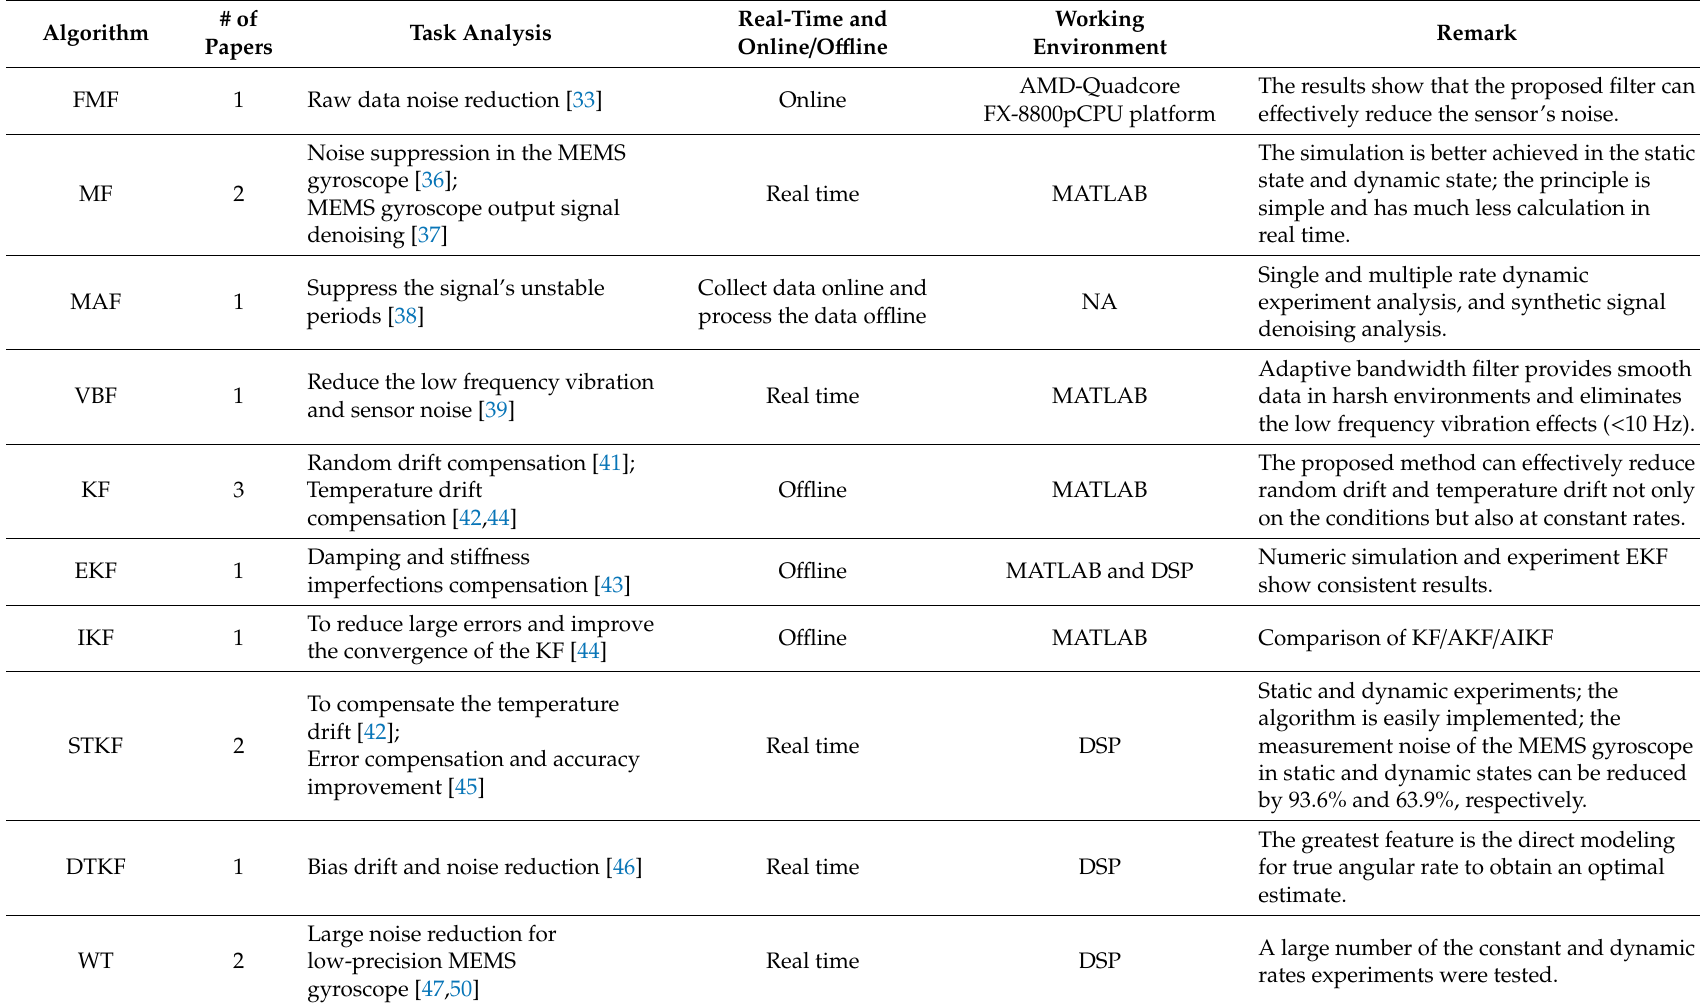
Table 1. Comparative analysis of existing algorithms with references status of task analysis and working